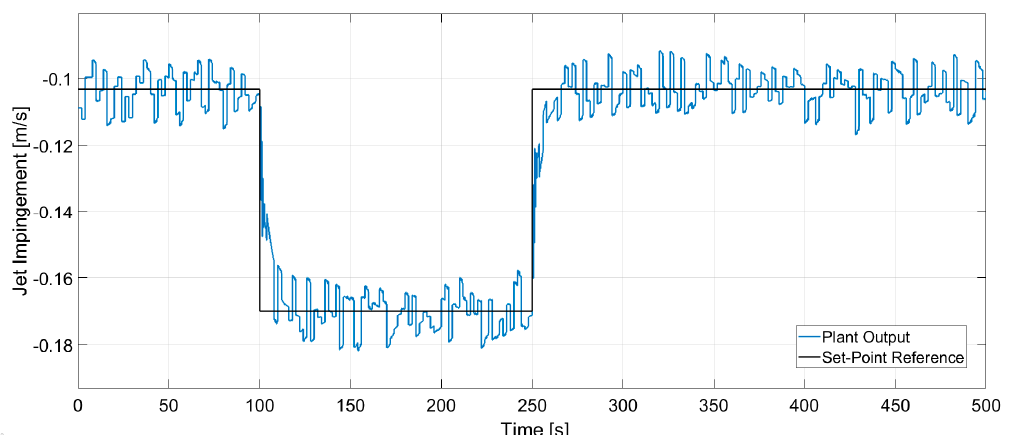
Figure 14. Closed loop response of jet impingement for set-point tracking. Sensors 2020 , 20 , x FOR PEER REVIEW